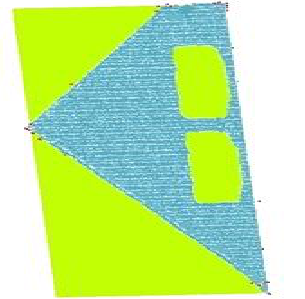
Figure 3. Superimposed convex hull, detected shape and point cloud in an occluded